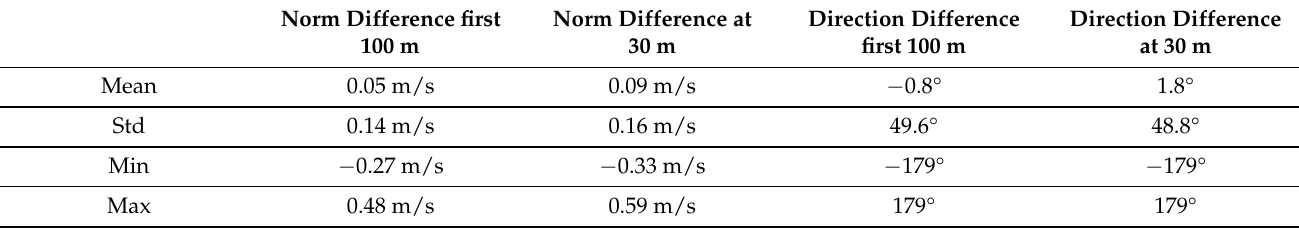
Table 2. Statistics on the differences between norms and directions of surface geostrophic velocities derived from satellite altimetry and S-ADCP velocities, at 30 m deep and averaged over the first 100 m. Those values were computed using all the R/V L’Atalante and R/V Maria S Merian sections with S-ADCP data